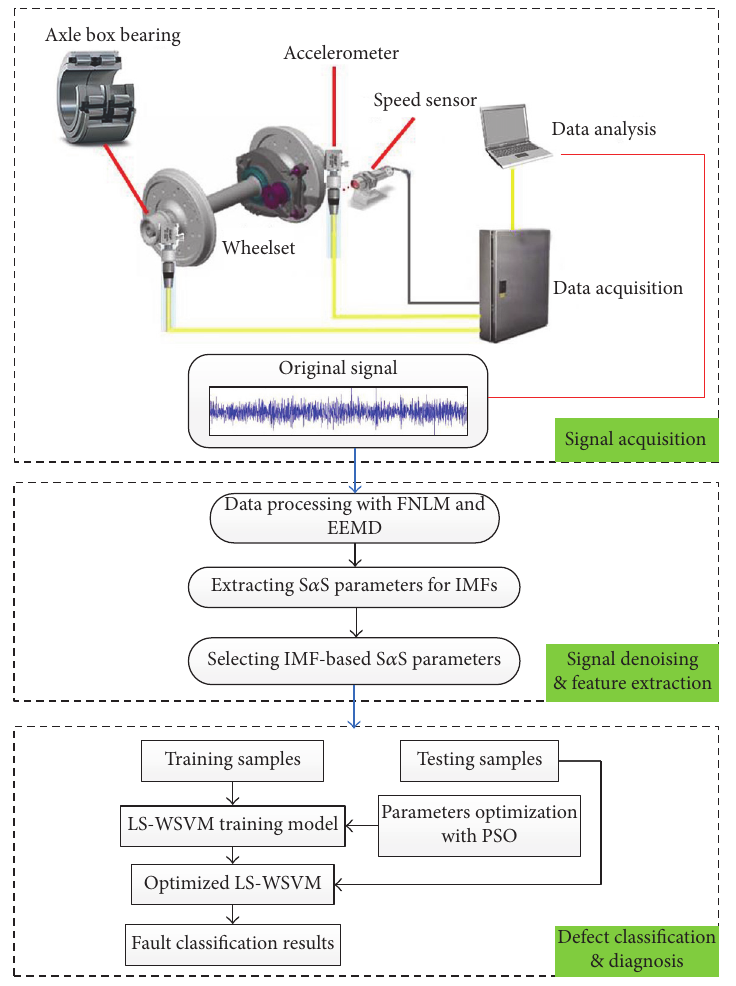
Figure 4: Structure diagram of the proposed fault diagnosis algorithm. Table 1: Geometrical parameters of the